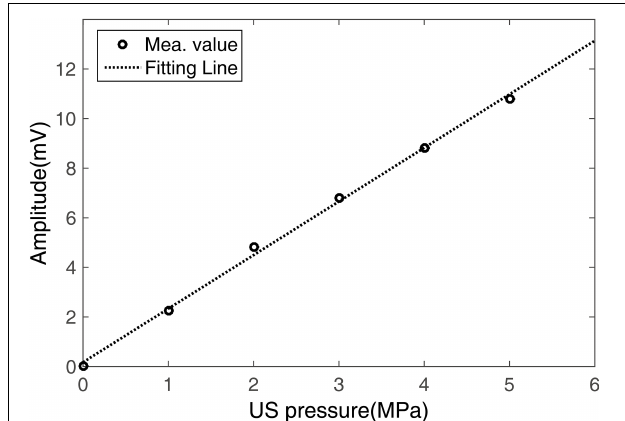
FIGURE 8 | Induced voltage of the test sample at different US